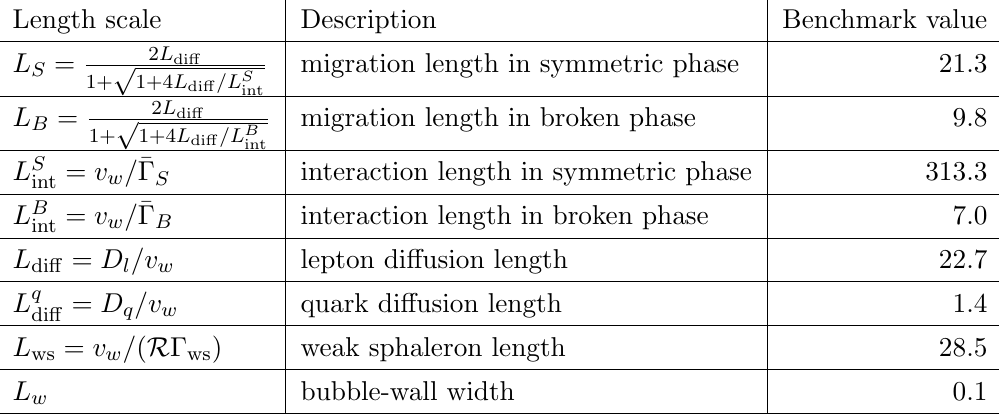
Length scales (in units of GeV (cid:0) 1 ) for a tau CPV source and their values for the benchmark values for the bubble-wall pro(cid:12)le given in section 2.1 and (cid:3) (cid:28) = 1 TeV. and without inclusion of the Higgs and quark sectors, that is from N( l; h; q; t ) and N( l ) respectively. The tau Yukawa coupling is su(cid:14)ciently small that decoupling the Higgs and quark sectors is an excellent